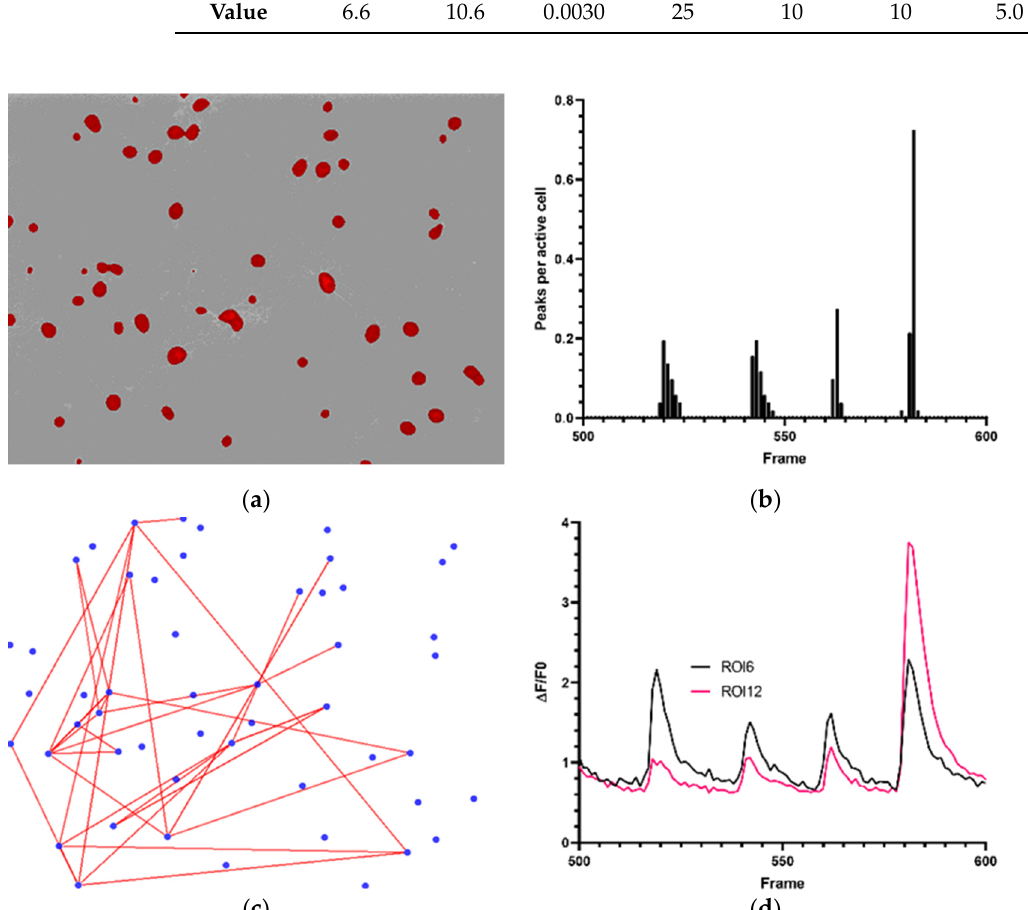
Figure 2. Neuronal activity of primary rat cortical cells. ( a ) 51 ROIs detected by CALIMA 2.0. ( b ) Average peaks per active cell in primary rat cortical cells between frame 500 and 600. ( c ) Proposed correlations between active primary rat cortical cells according to CALIMA 2.0 software (Pearson correlation factor of ≥ 0.7). ( d ) Calcium fluorescence trace of ROI6 and ROI12 between frames 500 and 600.